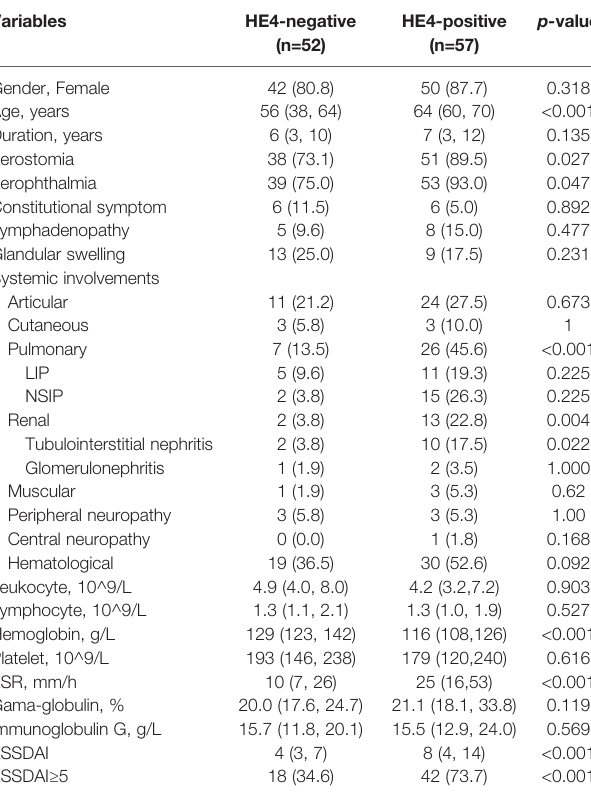
TABLE 3 | Clinical characteristics of patients with primary Sjögren ’ s Syndrome (pSS) between HE4-nagetive and positive groups *